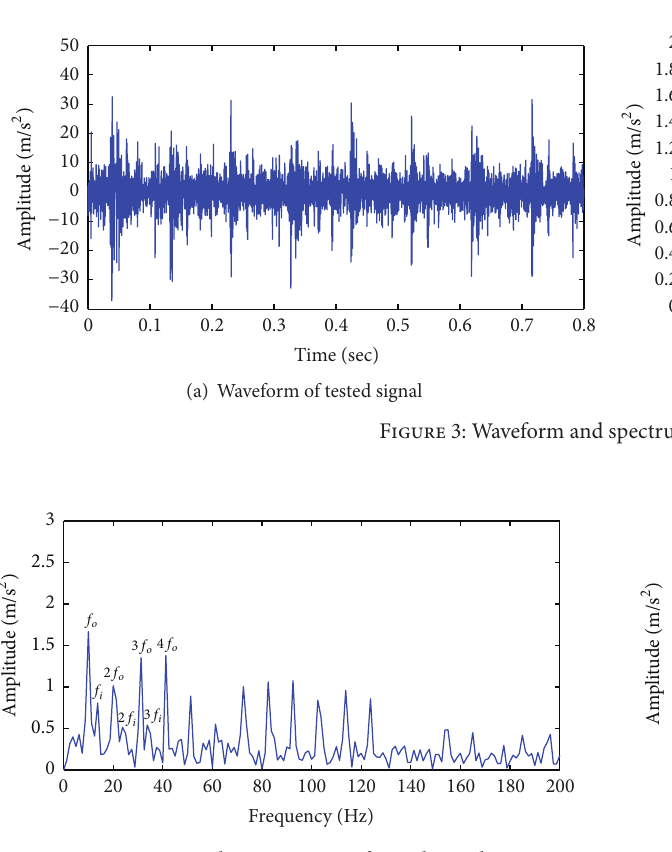
Figure 4: Envelope spectrum of tested signal.